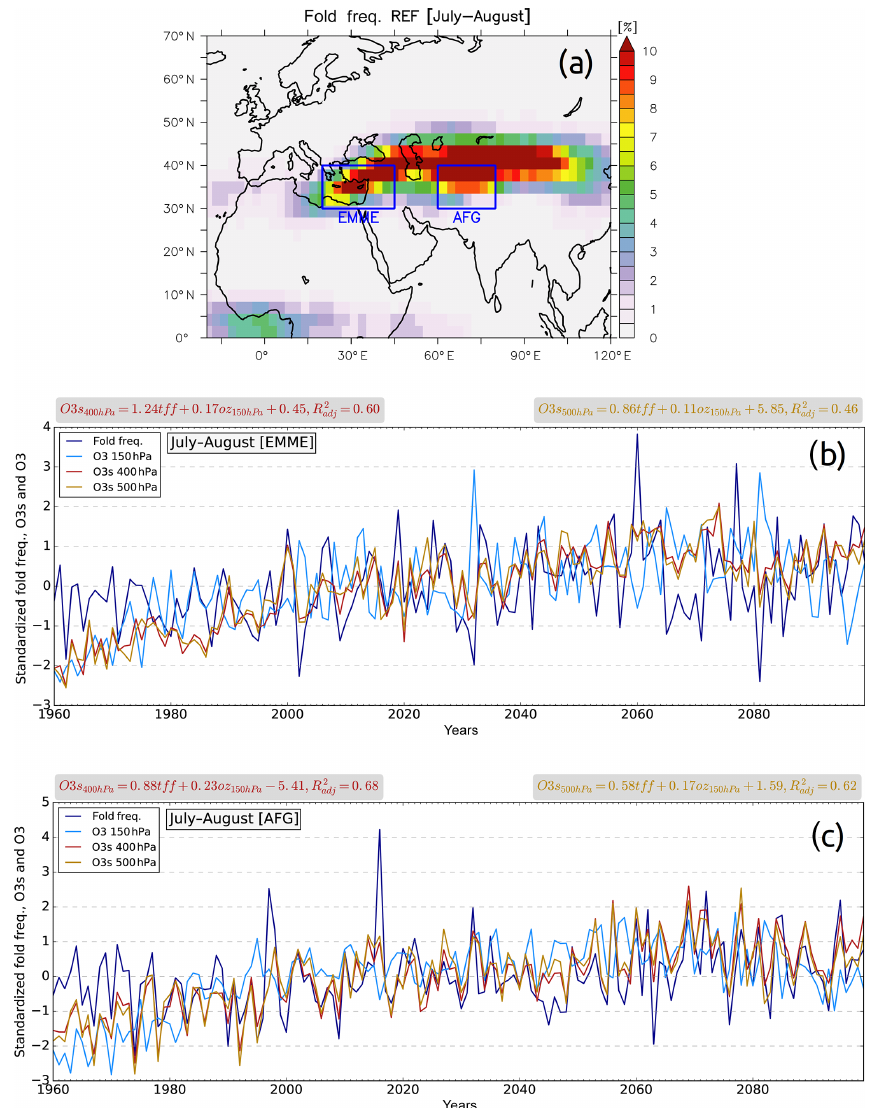
Figure 8. Mean July–August tropopause fold frequency (%) during the REF period and the examined EMME (20–45 ◦ E, 30–40 ◦ N) and AFG (60–80 ◦ E, 30–40 ◦ N) regions (a) . Time series of standardized mean July–August tropopause fold frequency (dark blue line), O3 at 150hPa (light blue line), O 3 s at 400hPa (dark red line), and O 3 s at 500hPa (orange line) over EMME (b) and AFG (c) for the period 1960–2100. Regression equations for O 3 s at 400 and 500hPa are also shown at the top of the charts with dark red and orange,